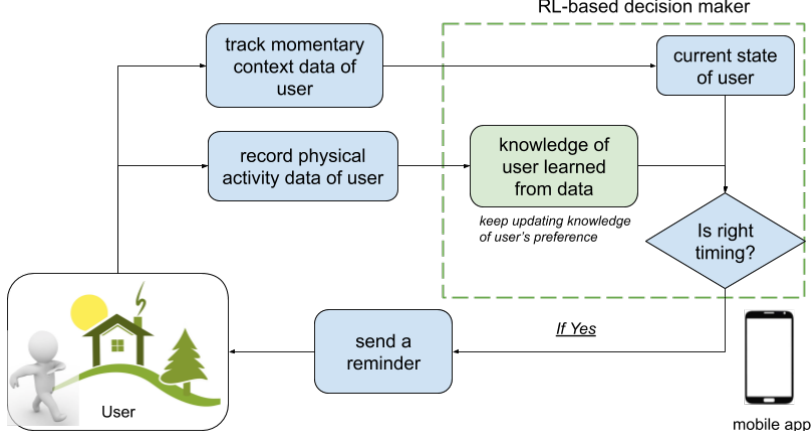
Figure 1. Overview of the reminder delivery procedure in the PAUL smartphone exercise application, regarding integration of a reinforcement learning